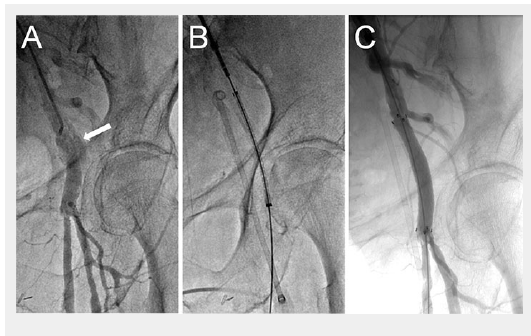
Screening of the iliofemoral arteries by fluoroscopy (A) and CT angiography (B).